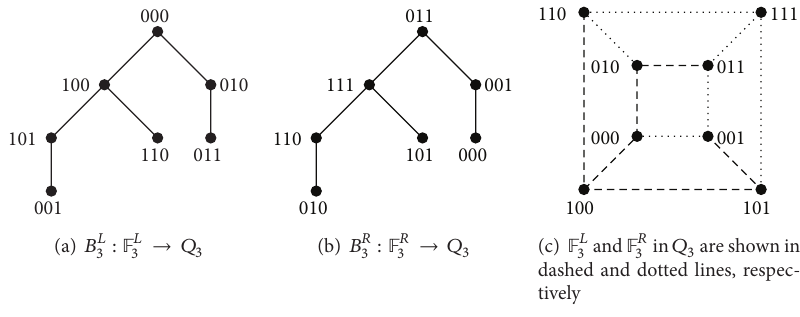
dashed and dotted lines, respec- tively